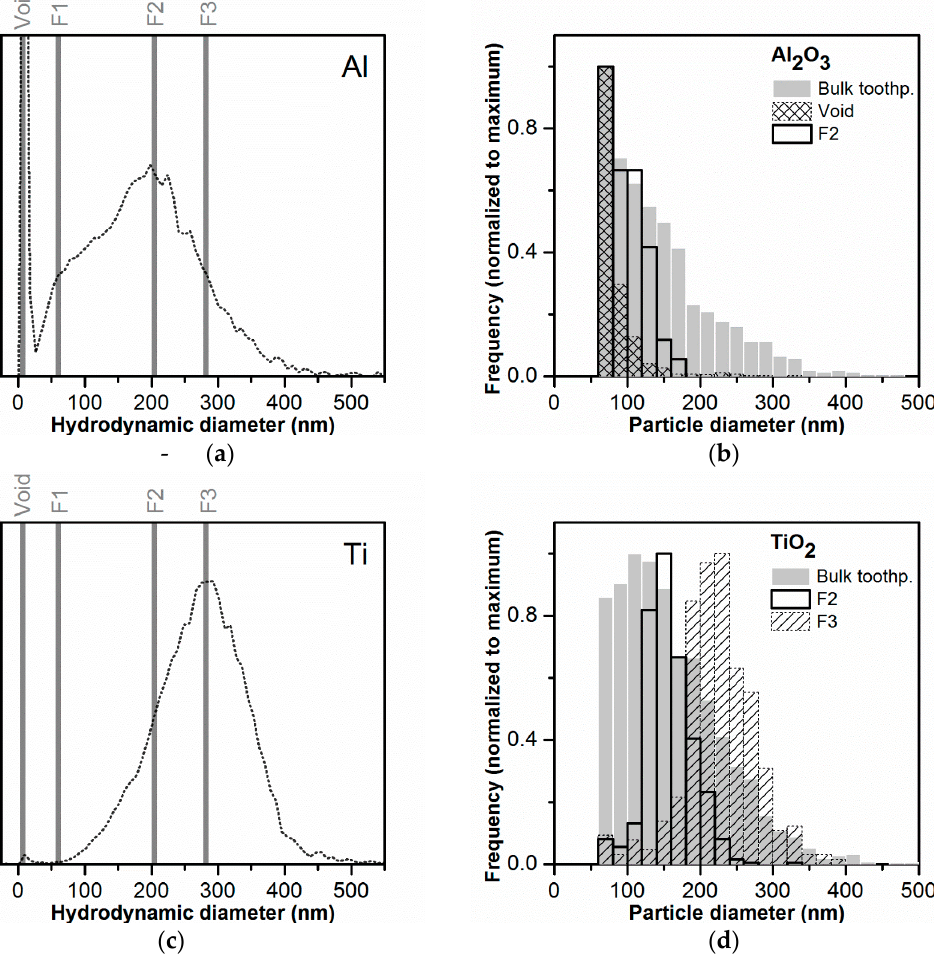
Figure 5. Fraction collection after toothpaste separation by AF4 and validation of the mass ‐ based PSD by spICP ‐ MS. ( a ), ( c ) Presentation of the collected fractions on the corresponding mass ‐ based PSDs. Fractions were collected at different time intervals corresponding to the void peak ( t r = 0.7–1.7 min), to the peak shoulder region observed in the Al mass ‐ based PSD (F1, t r = 7–8 min) and to the maximum of the Al and Ti mass ‐ based PSDs (F2 ‐ t r = 24–25 min and F3 ‐ t r = 33 ‐ 34 min, respectively) ( b ), ( d ) Number ‐ based PSDs for Al 2 O 3 and TiO 2 obtained after spICP ‐ MS measurements of the collected fractions and of the bulk toothpaste after sample preparation (not submitted to AF4 separation).